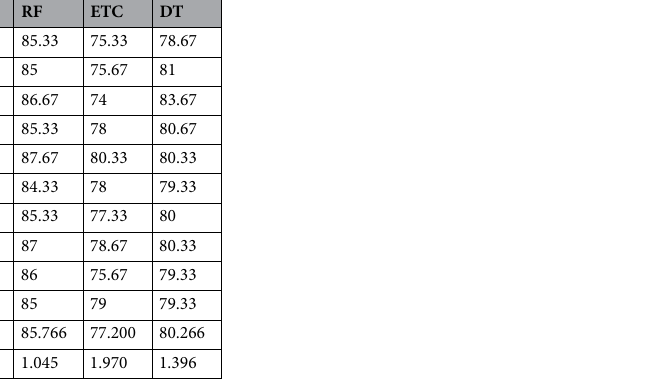
Table 4. Tenfold cross validation results